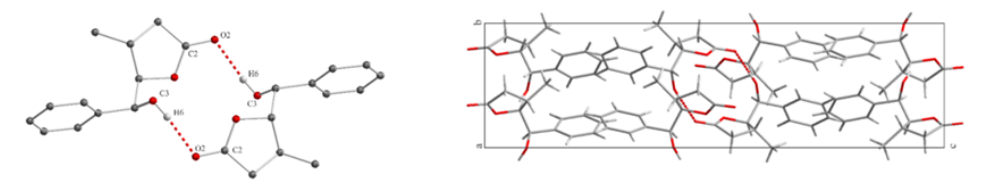
Figure 10. The arrangement of 13a in the unit cell box.